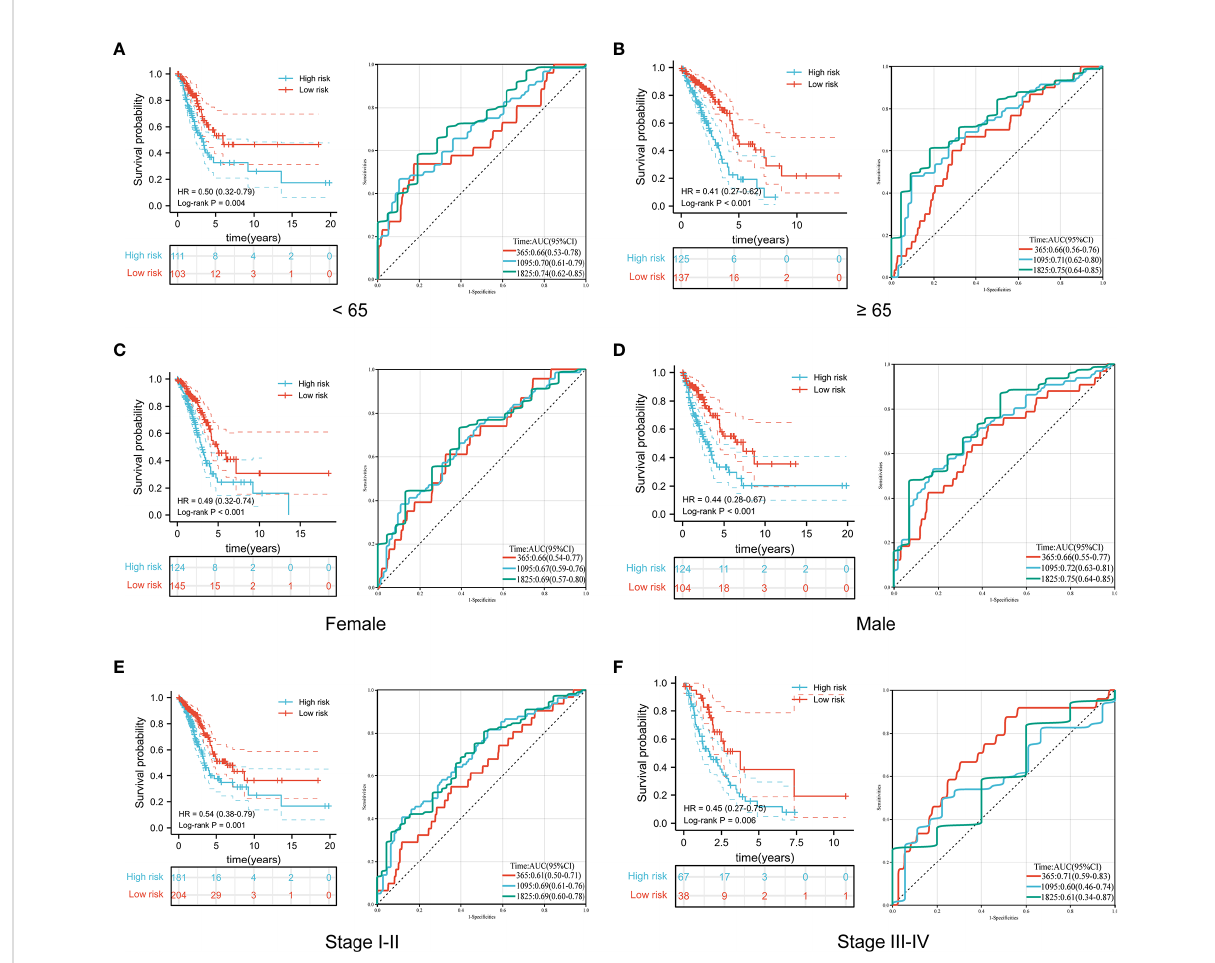
FIGURE 6 Comparison of overall survival and time-dependent ROC curves for LUAD patients of different ages (A, B) , sexes (C, D) , and pathological stages (E, F) between the high-risk and low-risk